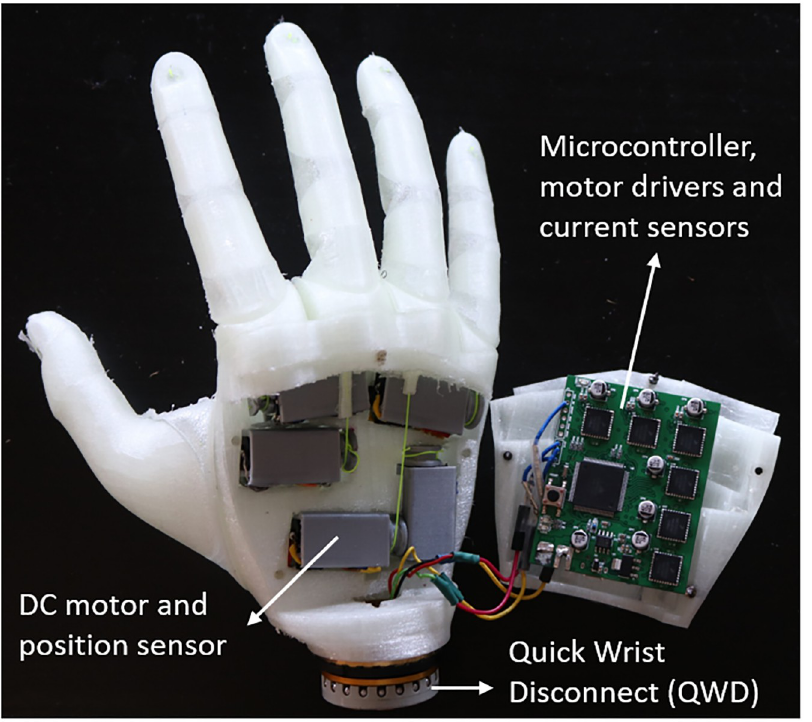
Fig 5. X-Limb actuation mechanism and control